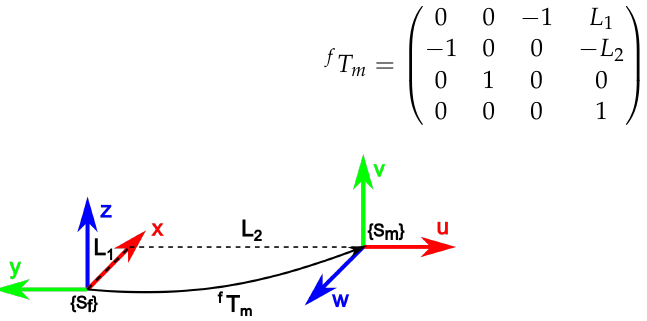
Figure 3. Example of CFs to define the pose of a mobile object.